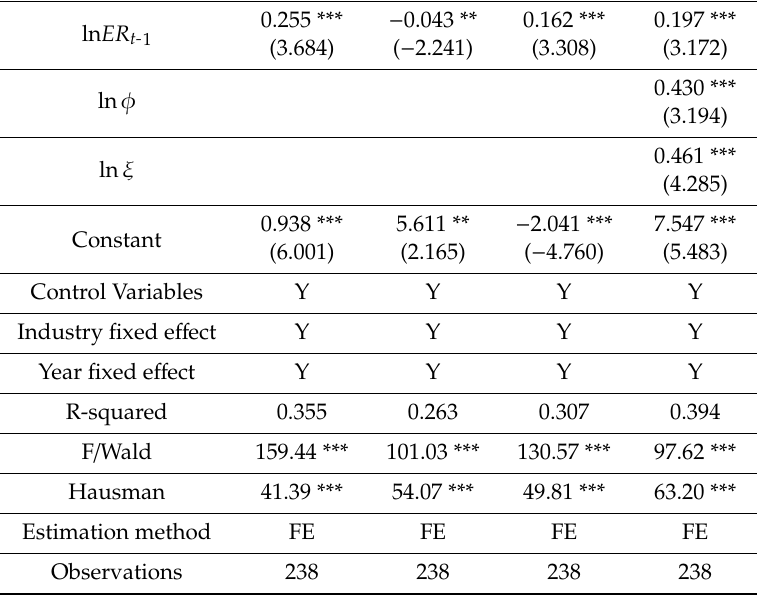
Panel C: Using the first-order lag of environmental regulation for